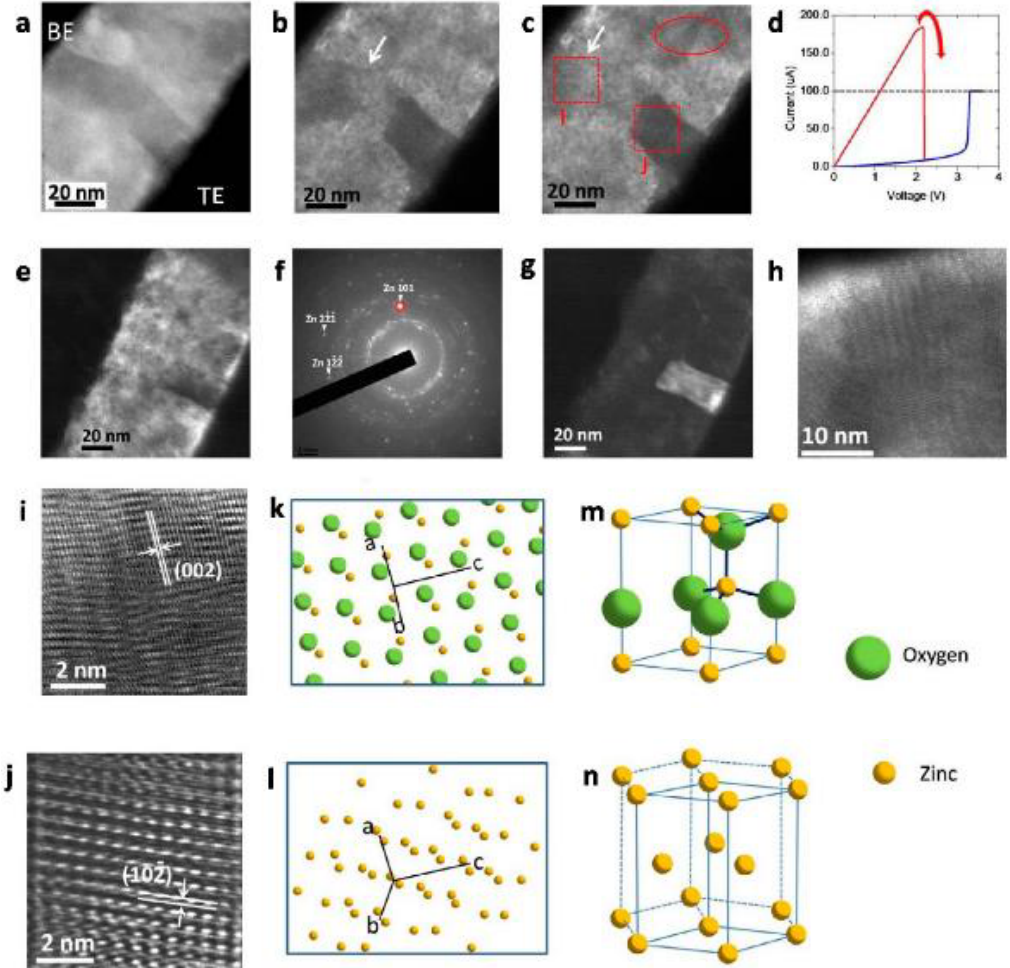
Figure 7: In situ TEM images of Pt/ZnO/Pt ReRAM explains the phenomenon of unipolar resistive switching during the process of reset (a) Initiation of the process of recording; (b) intermediate state; (c) Ultimate state of the ruptured filament upon accomplishment of reset pro- cess. (d) The corresponding I-V curve in red; the blue line corresponds to the forming process as a comparison. (e) Occurrence of multiple conductive filament elucidating the switching is caused by formation and rupture of multiple filaments. (f) The selected area diffraction pattern of the conductive filament in Figure 7e. where the red marked circle points to Zn (101) diffraction spot. (g) The corresponding dark- field image obtained from the diffraction spot marked as a circle in the diffraction pattern f. (h) In a high-magnification TEM image Moire fringes are observed at the disrupted region. (i) The conducting filaments were transformed back to ZnO 1− x along the ⟨ 110 ⟩ zone axis in the disrupted region.(j) The “zinc “conductive filament in the HRTEM image (j) The HRTEM of the “zinc “conductive filament along the ⟨ 231 ⟩ zone axis has been recognized. (k) Solid-sphere model of ZnO in a wurtzite structure along the ⟨ 110 ⟩ zone axis, where all the coordinate lines are the unit cell vectors. (l) Solid-sphere model of zinc in a HCP structure along the ⟨ 231 ⟩ zone axis. The 3-D schematic illustrations of (m) a ZnO unit cell and (n) a zinc unit cell, respectively, elucidating that the position of the zinc atoms remains unchanged as oxygen ions diffuse out. Reprinted with permission from J. Y. Chen, C.L. Hsin, C.W. Huang, C.H. Chiu, Y.T. Huang, SJ Lin, W.W. Wu, L.J. Chen// Nano Lett. 13 (2013) 3671 (C) 2013 American Chemical